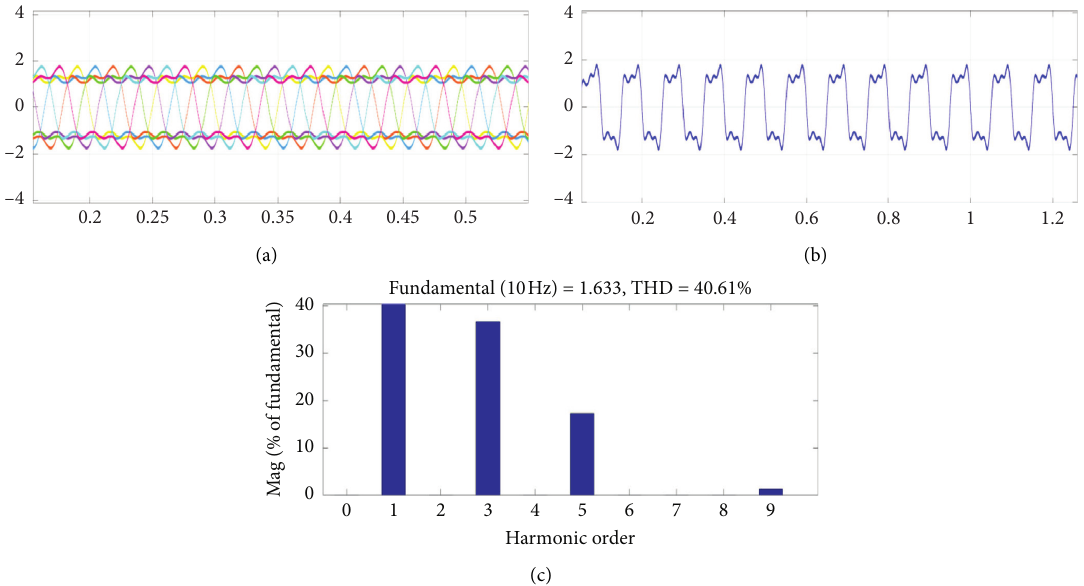
Figure 7: Simulation results of NTV-SVPWM, (a) seven-phase current waveform, (b) a phase current waveform, (c) FFT analysis.